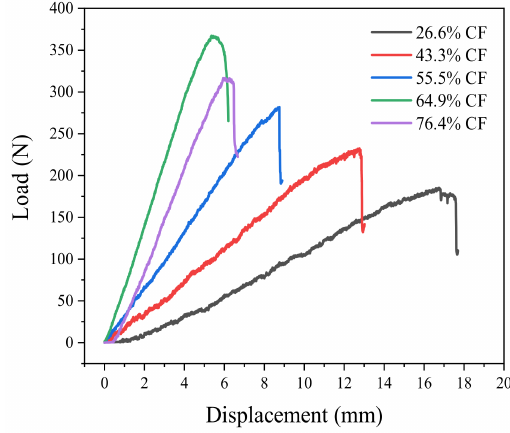
Figure 8. Load-deflection curve of the ENF test.